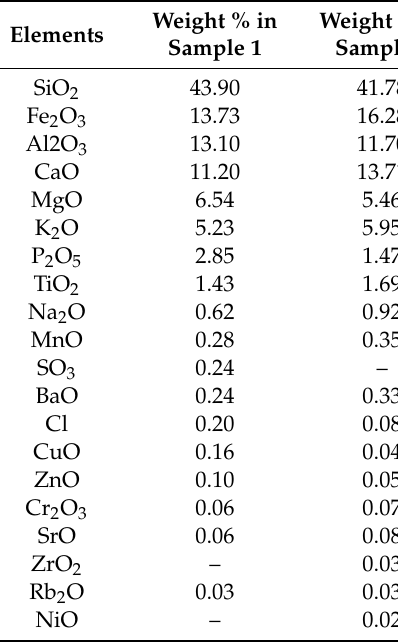
Table 1. Oxide composition of Segamat basalt from the XRF